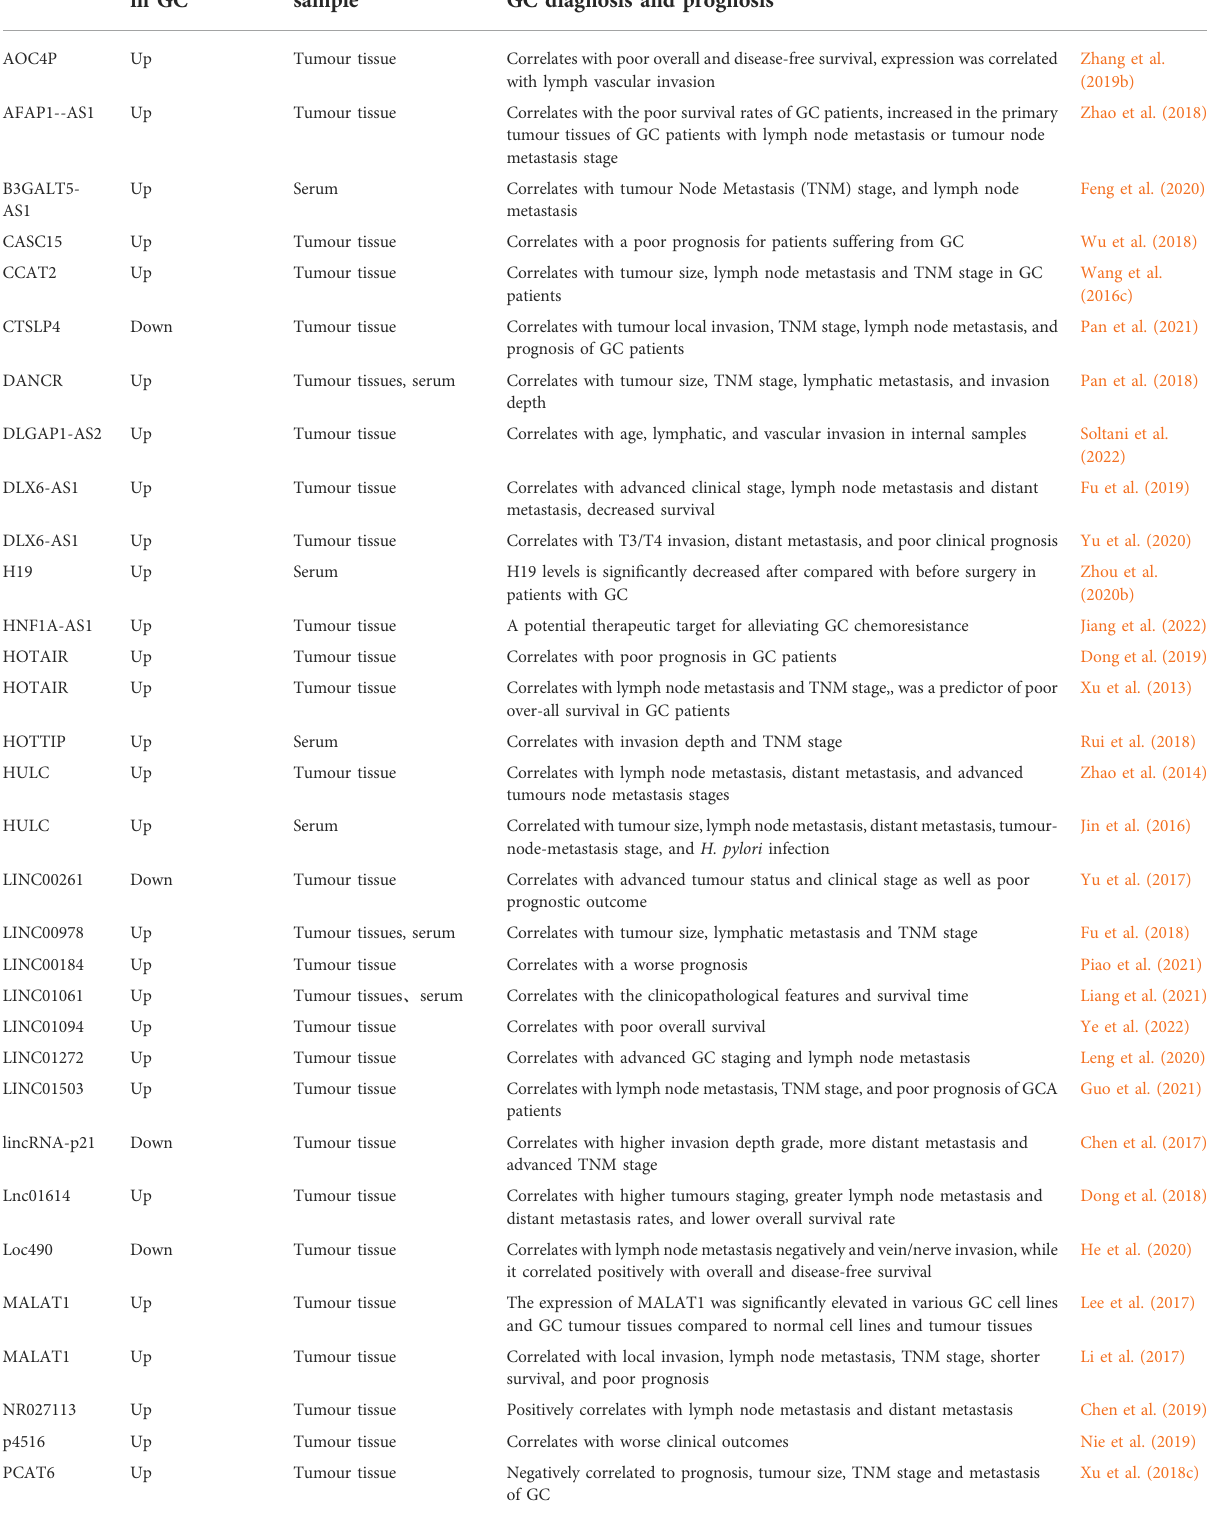
TABLE 4 The correlation between LncRNAs and diagnosis or prognosis in metastatic